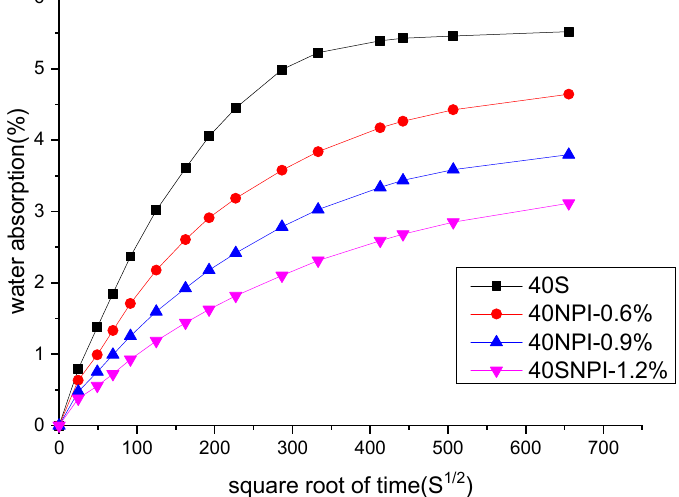
Figure 5. Water absorption of concrete with 0%, 0.6%, 0.9%, and 1.2% NPI respectively.